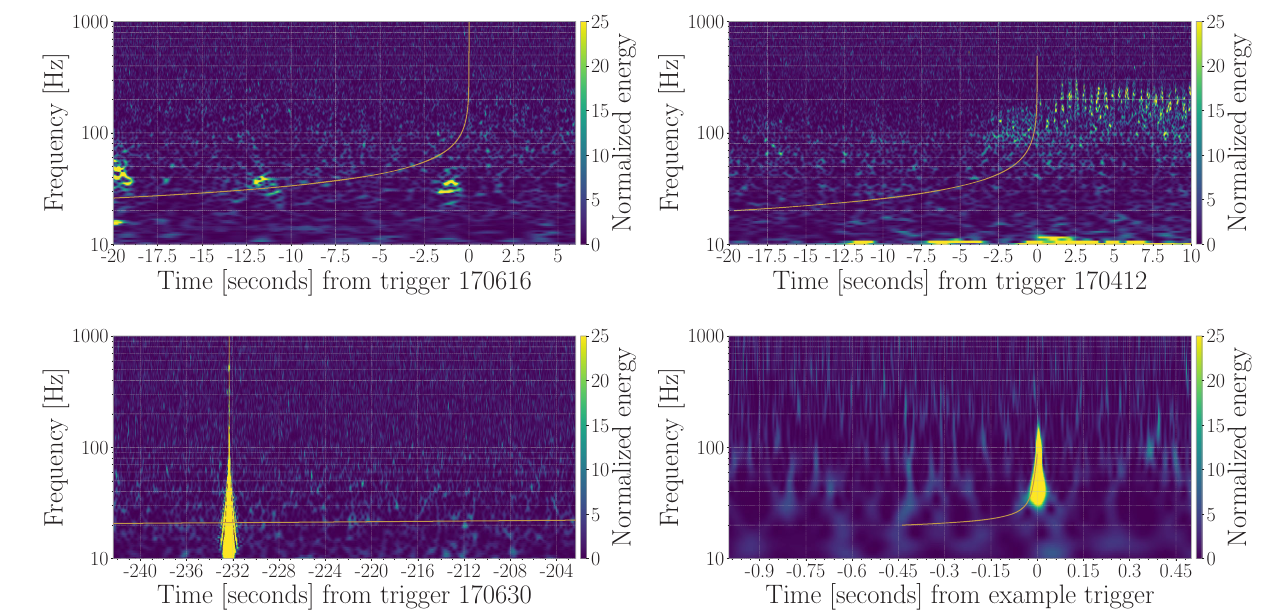
FIG. 15. Normalized spectrograms of the time around common noise artifacts with a time-frequency evolution of a related trigger template overlaid. Top left: Scattered light artifacts at Hanford with the template of trigger 170616 overlaid. Top right: A 60 – 200 Hz nonstationarity at Livingston with the template of trigger 170412 overlaid. Bottom left: A short-duration transient at Livingston with the template of trigger 170630 overlaid. Bottom right: A blip at Hanford with the template of a subthreshold high-mass trigger